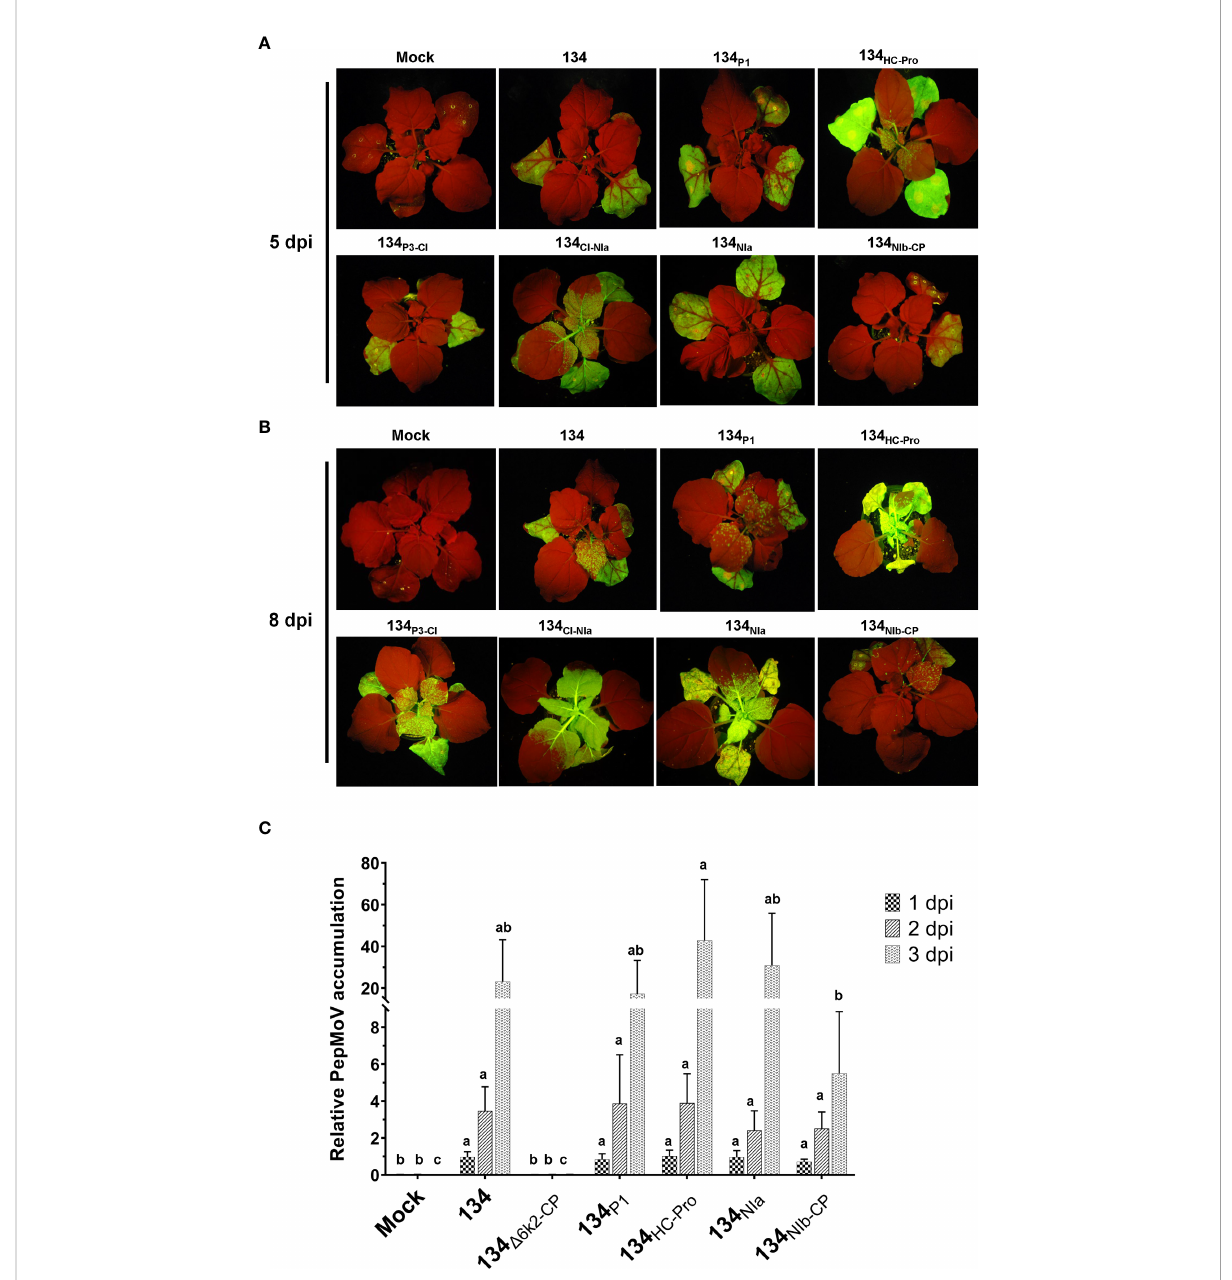
FIGURE 3 GFP fl uorescence representing chimeric viruses infection and symptom development of parental and mutant viruses on local and systemic leaves. PepMoV-134 and chimeric mutants were inoculated onto N. benthamiana plants by agro-in fi ltration. The plant age used for inoculation is around 3 weeks old. Differences in virus replication among 134 and mutant viruses were monitored from 5 to 12 days post-inoculation. (A) Results of inoculated leaves at 5 days post-inoculated (dpi). (B) Results of systemic leaves at 8 dpi. (C) Virus accumulation at 1 dpi, 2 dpi, and 3 dpi, respectively. Mean values with different letters above the bars indicate signi fi cant differences at P < 0.05 according to a one-way ANOVA and Duncan ’ s least signi fi cant range